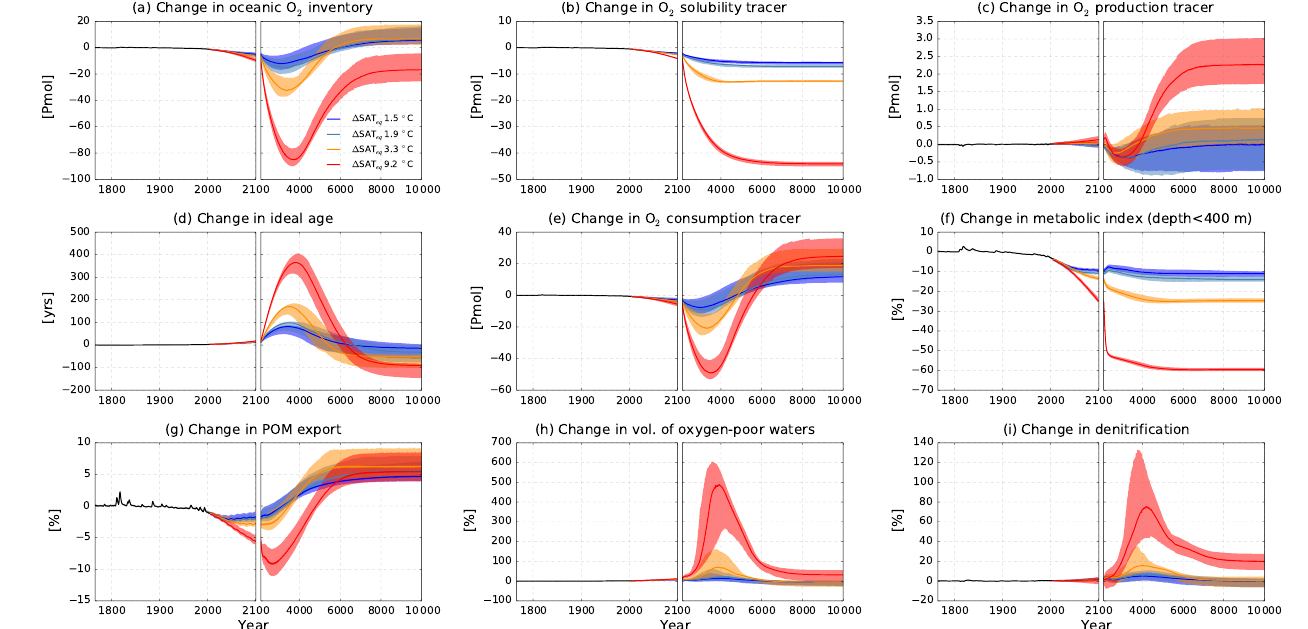
Figure 2. Temporal evolution of critical variables relative to 1870–1899 for model ensembles aiming at 1.5, 1.9, 3.3 and 9.2 ◦ C warming targets. Lines mark the median and shading marks the 90% range of the ensemble. The shading reflects uncertainties due to variations in the diapycnal mixing coefficient and the aerobic and anaerobic remineralization length scales of particulate organic matter ( α aerob and α denit ). (a) is the change in the total oceanic O 2 inventory. (b) O 2 solubility is the explicitly traced solubility component of oceanic oxygen, (c) is the explicit O 2 production tracer, and (e) is the explicit O 2 consumption tracer. (h) Oxygen-poor waters are taken as the volume of water with O 2 < 50mmolm − 3